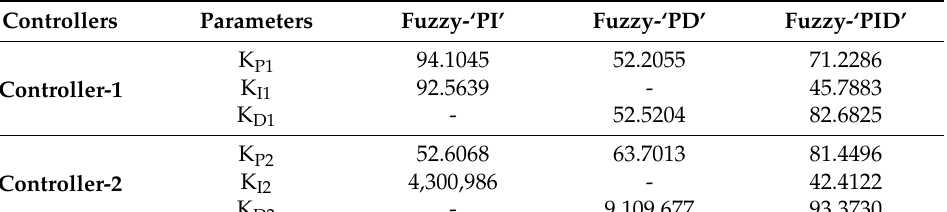
Table 6. Optimal parameters for both control 1 and 2 using ABC algorithm for Case 1 (1% step change in load).